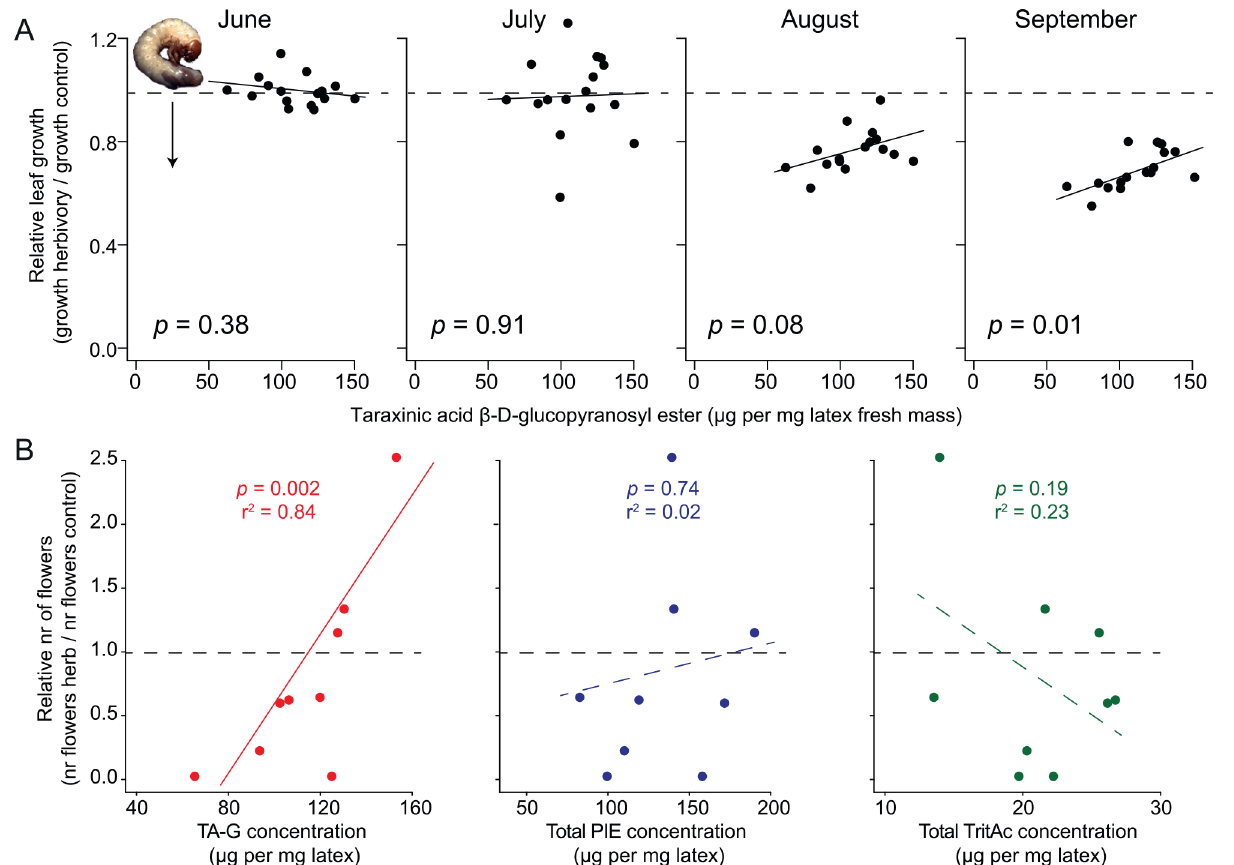
Fig 5. TA-G reduces the negative effect of M . melolontha on plant vegetative and reproductive performance in the field. A. TA-G concentration was positively correlated to relative leaf growth across 17 T . officinale genotypes in a common garden experiment towards the end of the growing season. Relative leaf growth is the mean leaf growth of herbivore-infested plants of each genotype during the infestation period compared to the mean leaf growth of the control plants of each genotype (leaf growth: increase in maximal leaf length compared to maximal leaf length before infestation). Data points below the horizontal dashed line indicate reduction in leaf growth under M . melolontha attack. Each data point represents the mean of one genotype. Plants were infested at the end of June. Statistics of Pearson ’ s product-moment correlations based on mean values per genotype are shown. B. The relative number of flowers (number of flowers of the herbivore-infested plants expressed relative to noninfested plants of each genotype) was positively correlated with the concentration of TA-G, but not with the total concentrations of PIEs or TritAcs at the beginning of the flowering season. Only genotypes that flowered at this time point are shown (9 out of 17 genotypes). Underlying data can be found in S1 Data.